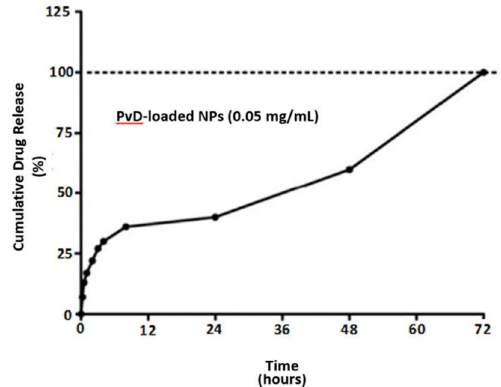
Figure 4. In vitro drug release of Parvifloron D-loaded nanoparticles at 0.05 mg/mL, for 72 h, in phosphate buffered saline (PBS) pH 7.4 solution. Results are expressed as mean of measurements of three independent nanoparticles lots ± Standard Deviation (SD) ( n = 3).